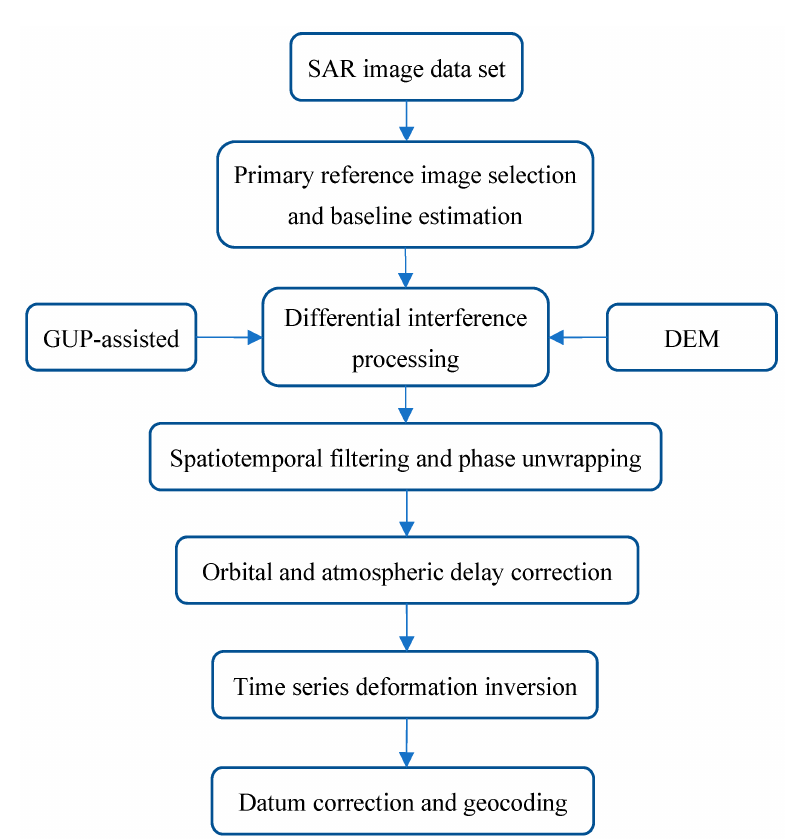
Figure 4. SBAS-InSAR data processing flow.